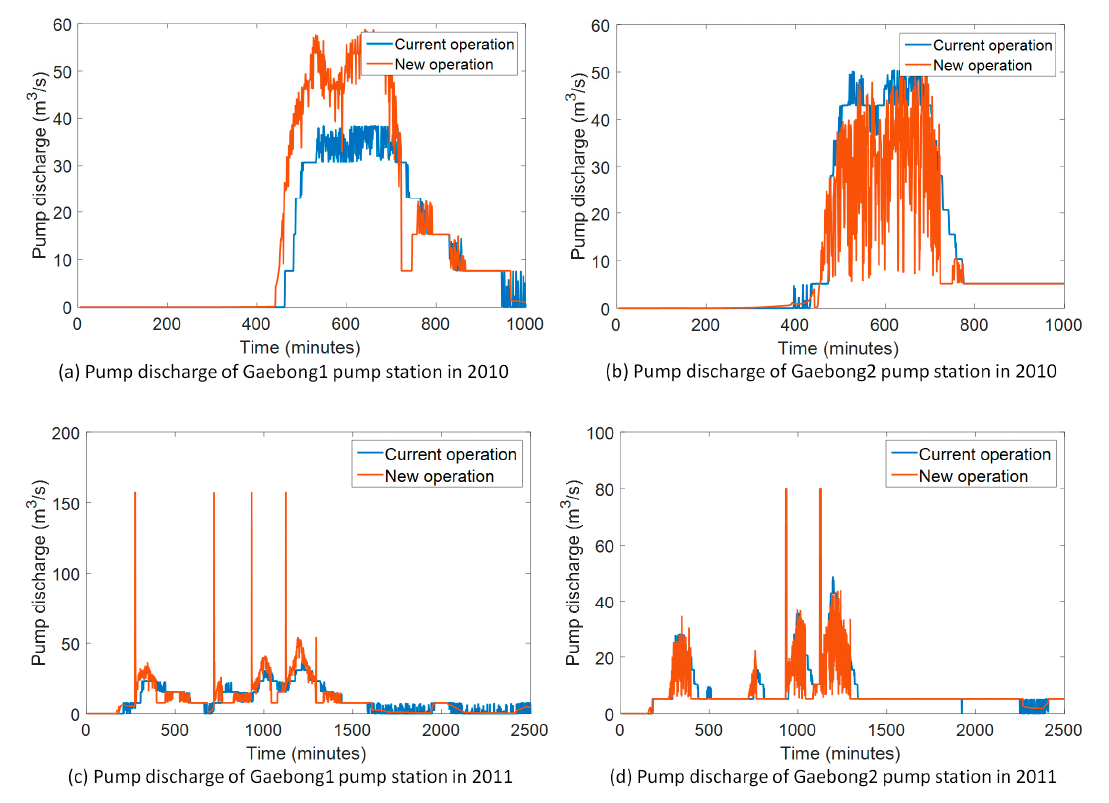
Figure 12. Pump discharge over time for the current and new operations.